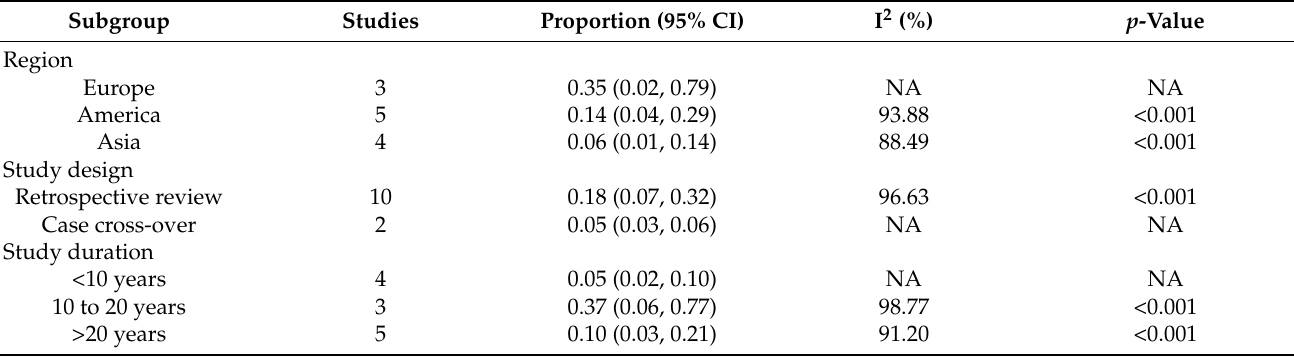
Table 4. Results of subgroups analyses.